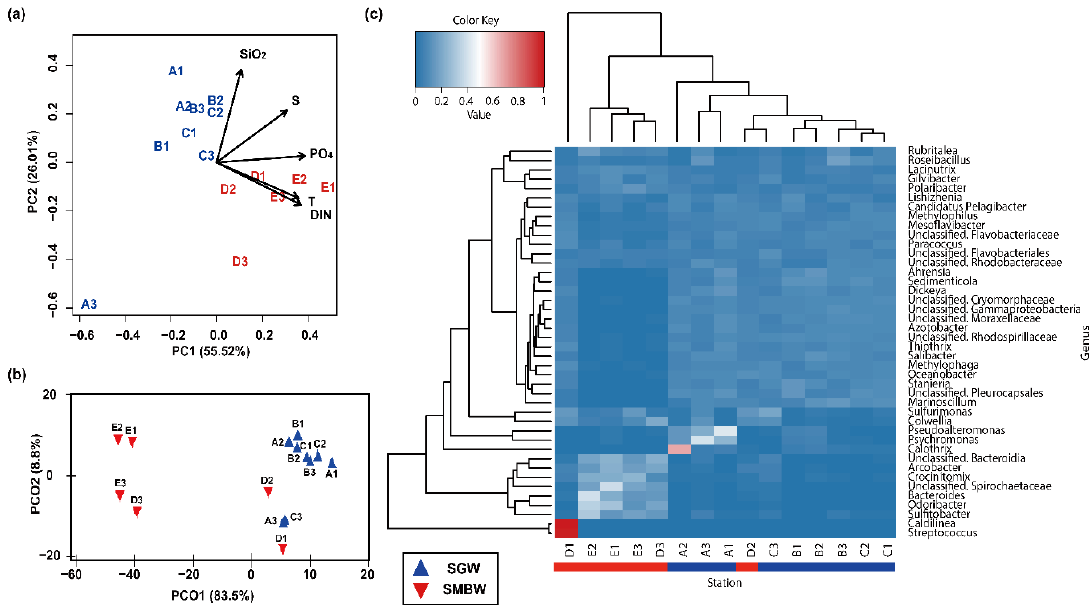
Figure 4. ( a ) Principal component analysis (PCA) ordination biplot of sampling stations with environmental parameters (physical: T and S; biogeochemical: DIN, PO 4 , and SiO 2 ). The two components (PC1 and PC2) explained 73.46% of the total variation in environmental data. ( b ) Principal coordinates analysis (PCoA) ordination plot of Bray‒Curtis dissimilarity calculated from the relationship between bacterial community composition at the genus level and environmental parameters using PERMANOVA analysis (F statistic = 15.6 with p < 0.001). ( c ) Heatmap shows the relative abundance at the genus level (>1 % in a total sum of relative abundance of all stations), and the dendrogram shows the hierarchical clustering of each bacterial taxa and station. Microorganisms 2020 , 8 , x FOR PEER REVIEW